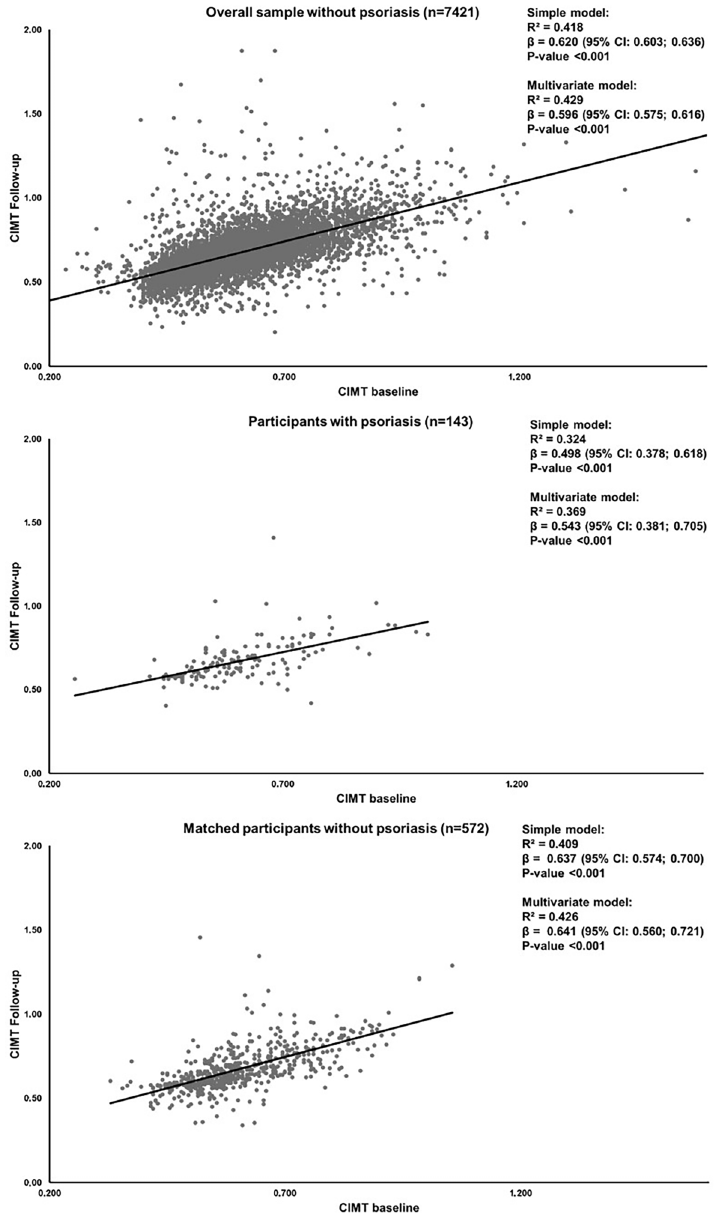
Figure 3. Scatterplot between baseline vs follow-up values of carotid intima-media thickness (CIMT), according to psoriasis diagnosis. b : angular coef fi cient of linear regression; CI: con fi dence interval. Multivariate model was simultaneously adjusted for age, sex,